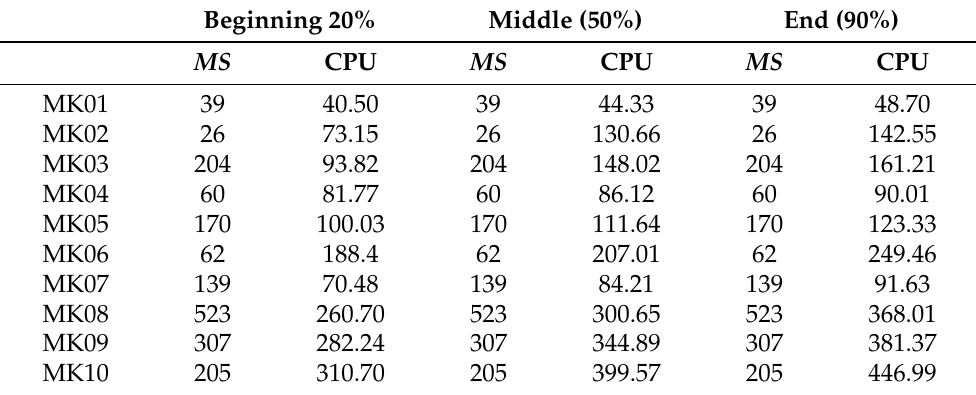
Table 12. E2L-PSO soft CPU reduction needed